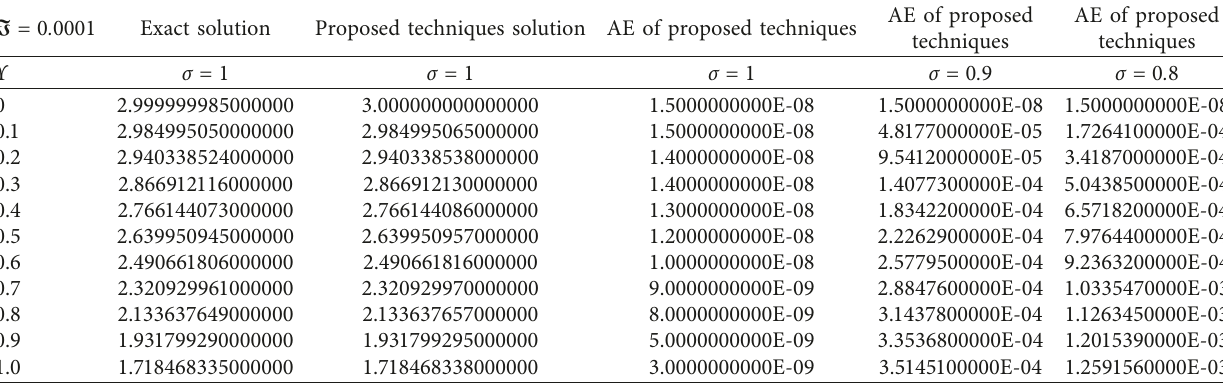
Table 1: Comparison of the proposed method and exact results with absolute error (AE) at various fractional order for φ ( ξ , I ) of problem 1. I � 0 . 0001